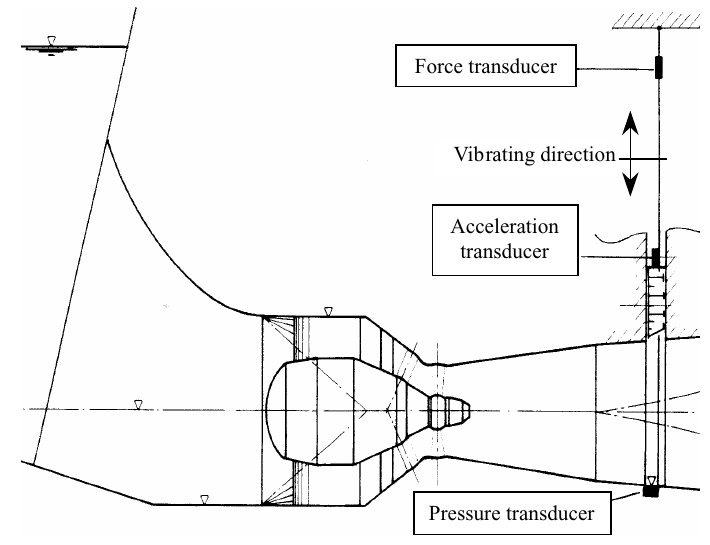
Fig. 2. Transducer arrangement at tested model.